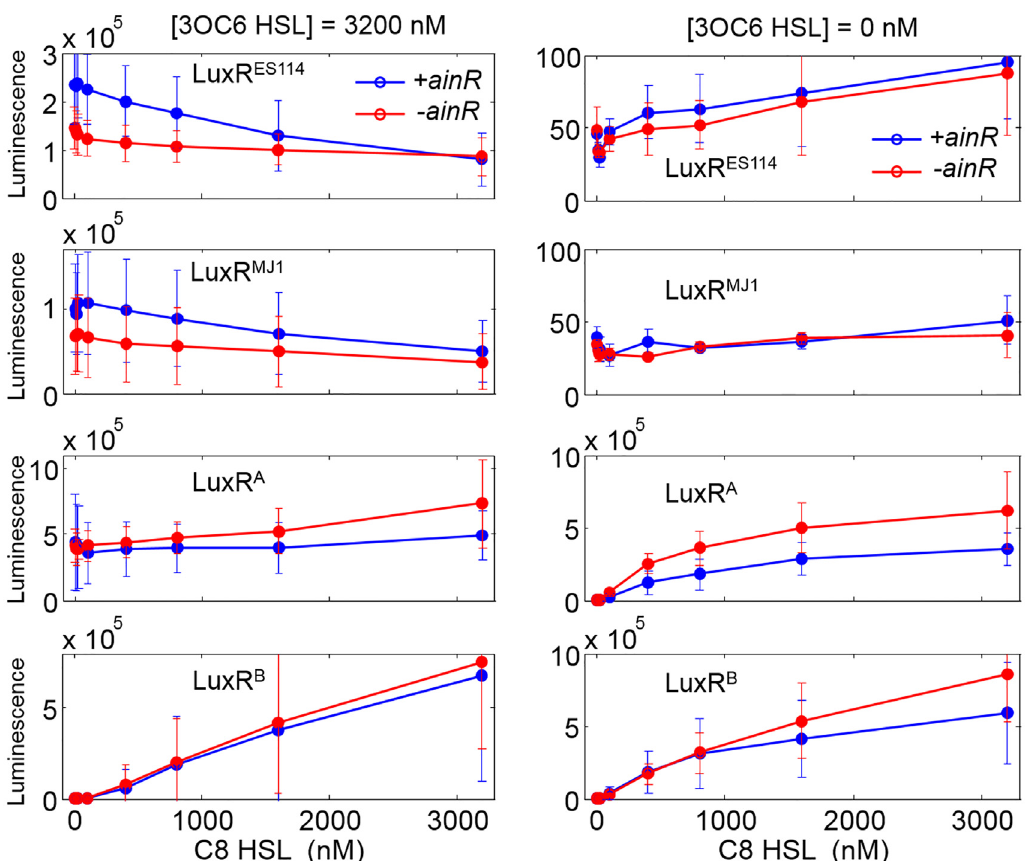
Fig 4. Effect of Δ ainR on the response to C8-HSL. Each panel shows the luminescence of a LuxR variant in both ainR+ (blue) and ainR- (red) background. Left panels show results in the presence of 3.2 μ M 3OC6-HSL and right panels show results in absence of 3OC6-HSL. All data are the average of at least three independent replicates. Error bars indicate standard deviation of the replicates. Luminescence is given in units of detector counts.